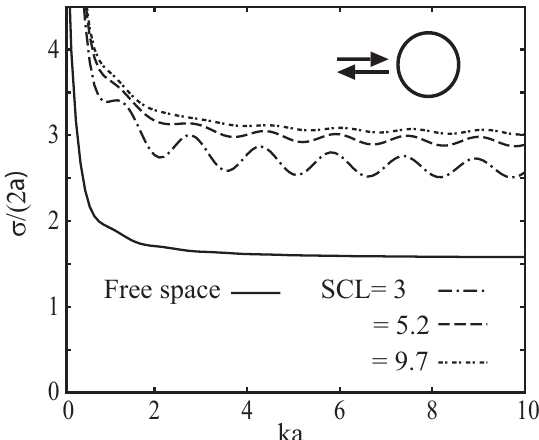
Figure 3. Target size versus RCS in free space, at three SCLs and at δ = 0 for plane wave incidence.